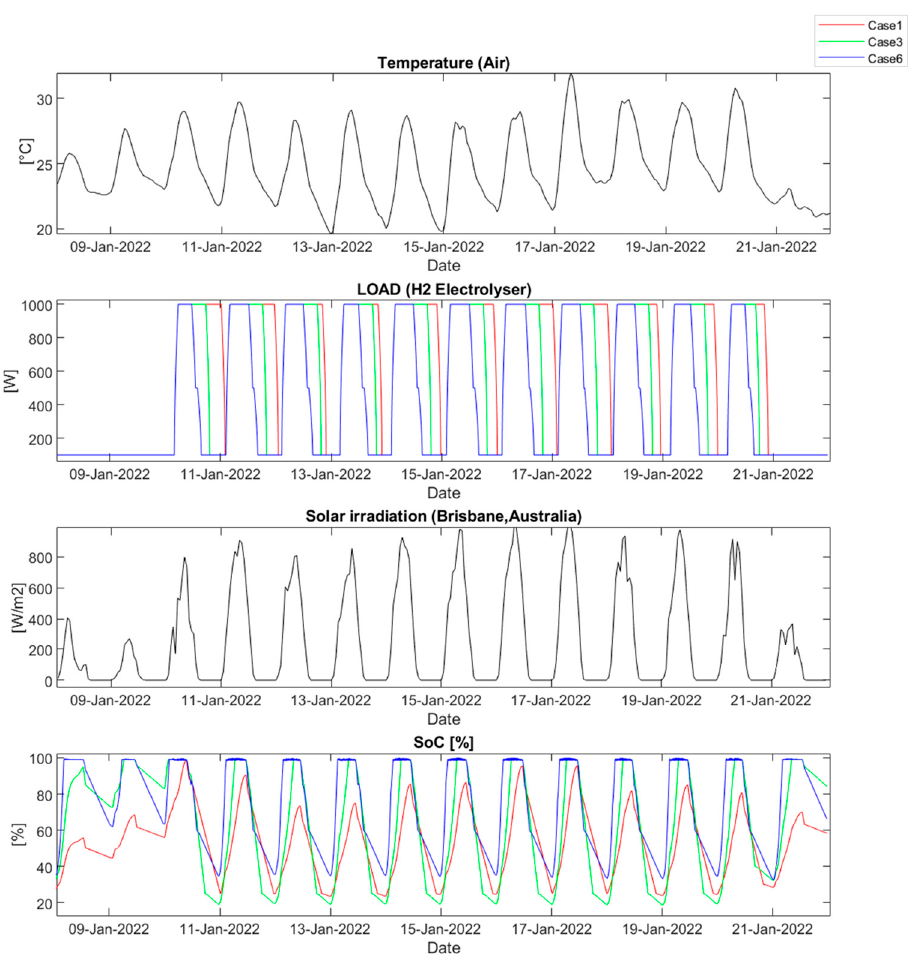
Figure 11. Simulation of 14 days of the system showing the temperature, irradiation, electrolyser load and SoC for cases 1,3 and 6. These results are from LiB ES simulation.